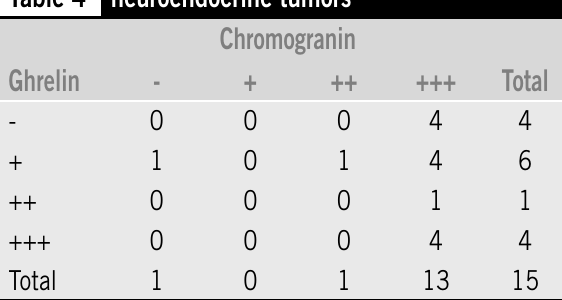
Study of correlation between the degree of immunohistochemical reaction for ghrelin and chromogranin in 15 gastric type I